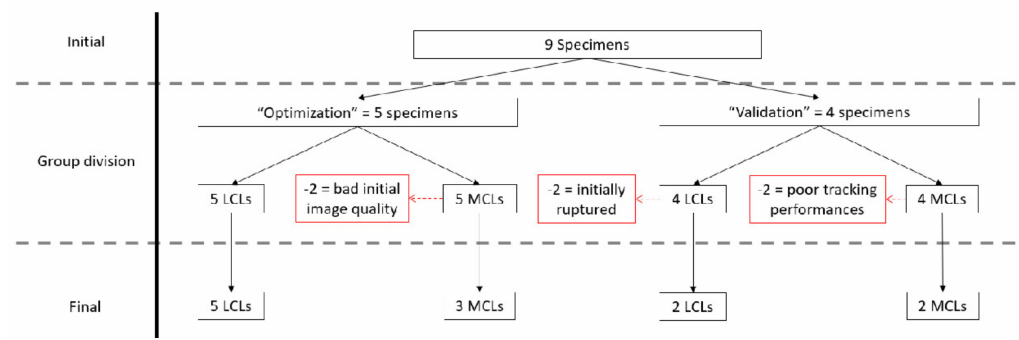
Figure 6. Flowchart of the specimen selection, from the initial population to the final valid specimens. Ligaments were discarded from the initial population (red) based on the initial conditions of the ligament, initial image quality analysis and tracking